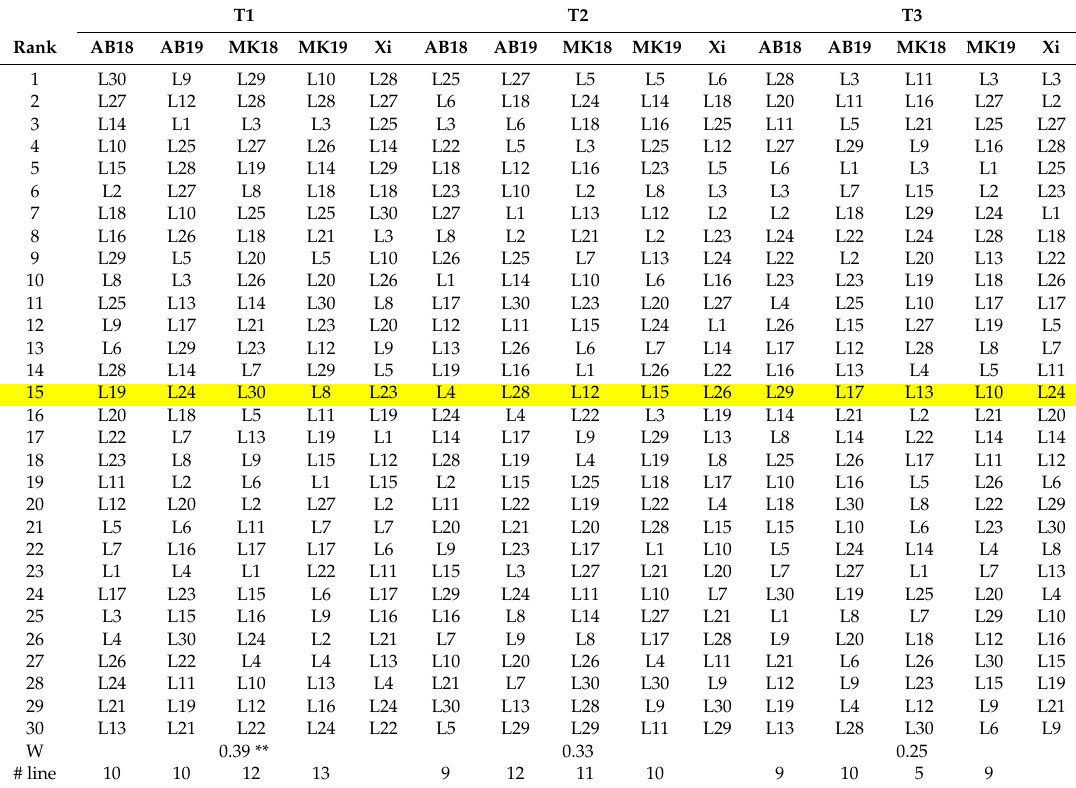
Table A7. Ranking of Striga -resistant inbred lines based on average yield (kg / ha performance across each environment in the combined analysis at Abuja and Mokwa, Nigeria for each tester in the Striga -non-infested condition. T1